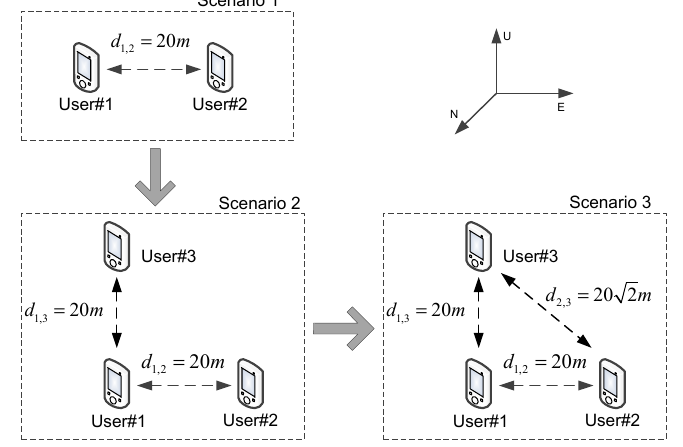
Figure 7. User distribution with new collaborative link and